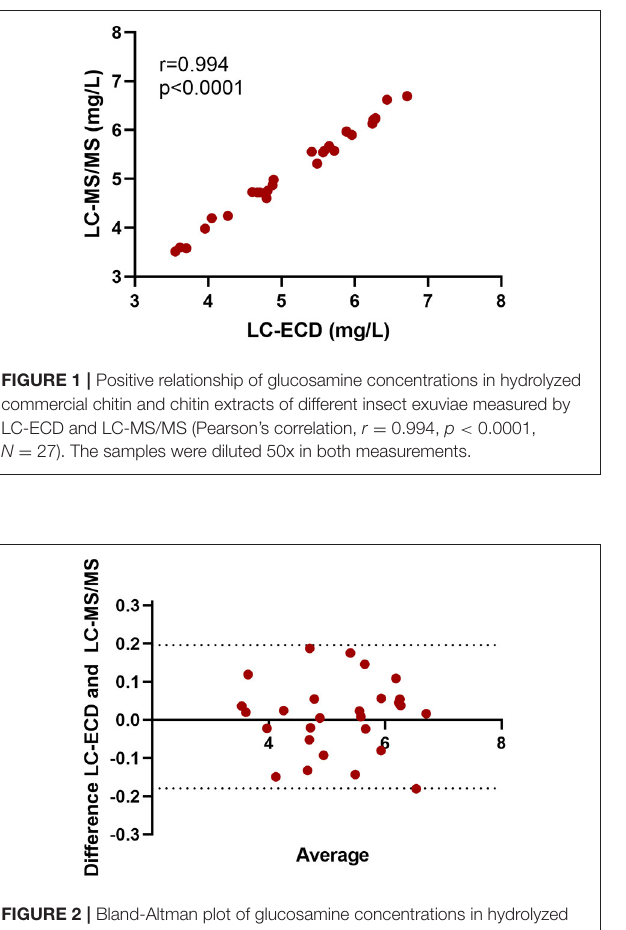
( Figure 2 ). The scattered distribution of the sample points indicated no systematic trend in variation, and the variation was not dependent on the use of different detection